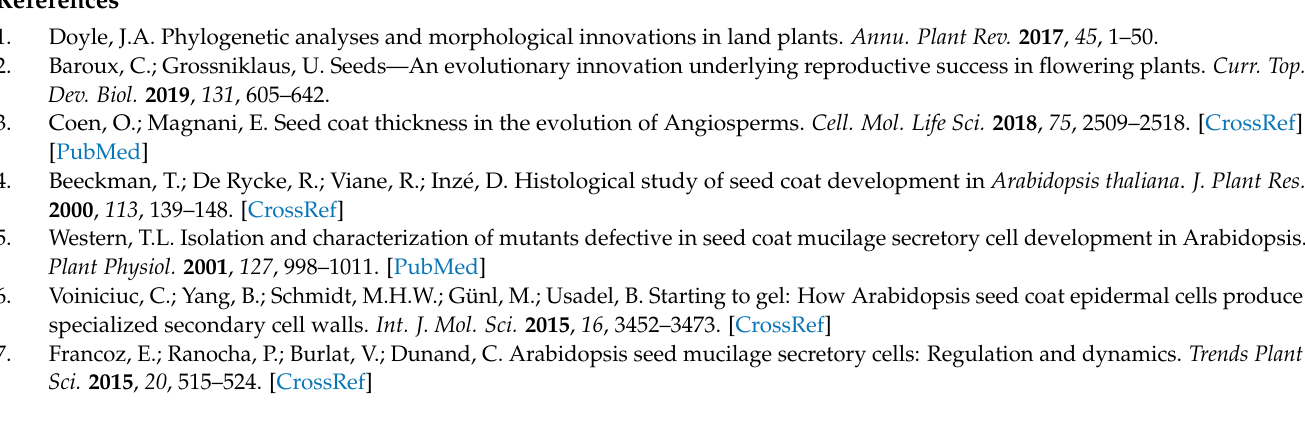
List and Genomics data origin of the 32 species used in this study, Table S4: Detailed genomic data mining of A. thaliana MSC toolbox gene orthologs among Brassicaceae species, Table S5: Sorting of the studied species according to the myxospermy occurrence highlights the absence of correlation with the presence of A. thaliana MSC tool box gene orthologs related to mucilage synthesis in Arabidopsis , Table S6: Sorting of the studied species according to the columella occurrence highlights the absence of correlation with the presence of any A. thaliana MSC tool box gene orthologs, Table S7: Sorting of the studied species according to their opening zone of the primary cell wall that allows the mucilage extrusion highlights the absence of correlation with orthologs from the genes controlling the opening mode in A. thaliana , Table S8: Sorting of studied genes according to their polysaccharide-related functions highlights the absence of correlation with the occurrence of myxospermy, Table S9: Sort- ing of studied genes according to their impact in myxospermy (strength of the phenotype in the corresponding mutant) highlights the absence of correlation with the occurrence of myxospermy, Table S10 (Related to Figure 8): Comparison of the relative expression values of A. thaliana MSC tool box gene orthologs between A. thaliana , C. sativa , B. napus and A. arabicum whole seed development illustrates their higher relative expression values in A. thaliana